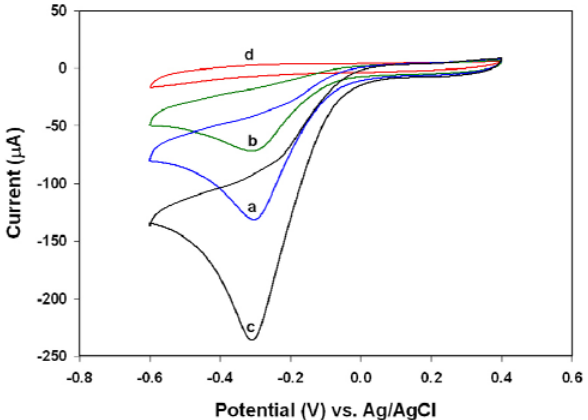
for 10 minutes (black). 2